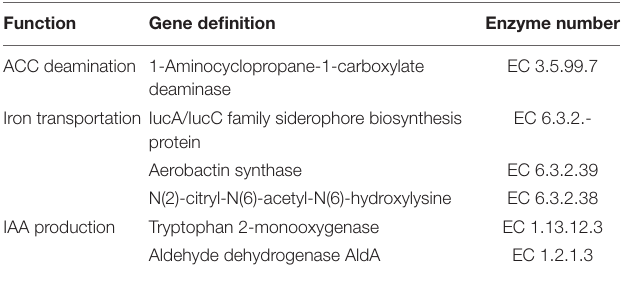
TABLE 2 | Genes involved in plant growth promotion in the genome of Streptomyces lincolnensis L4. Function FIGURE 7 | Quantitative PCR revealed the differential expression of genes